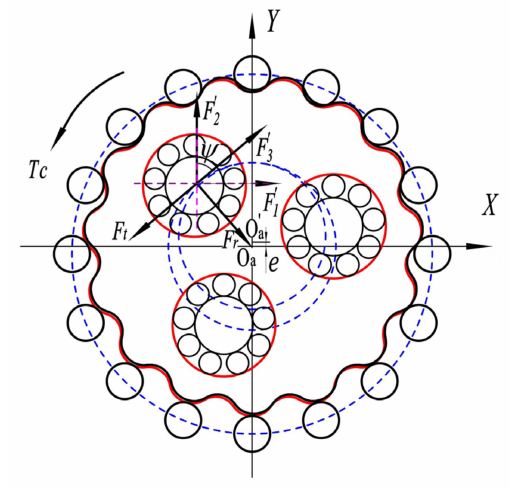
Figure 5. Force analysis of the arm